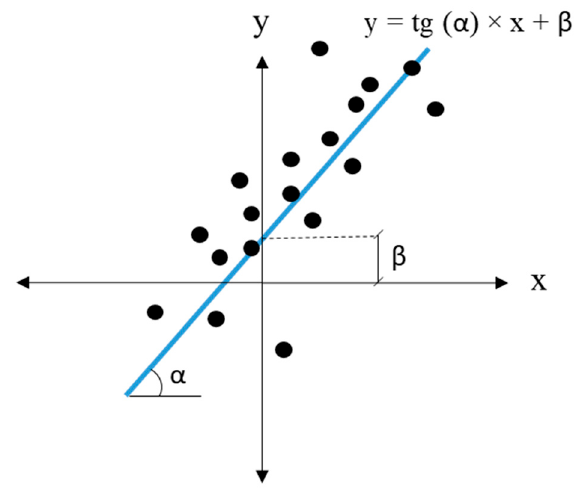
Figure 4. A simple view of linear fitting.